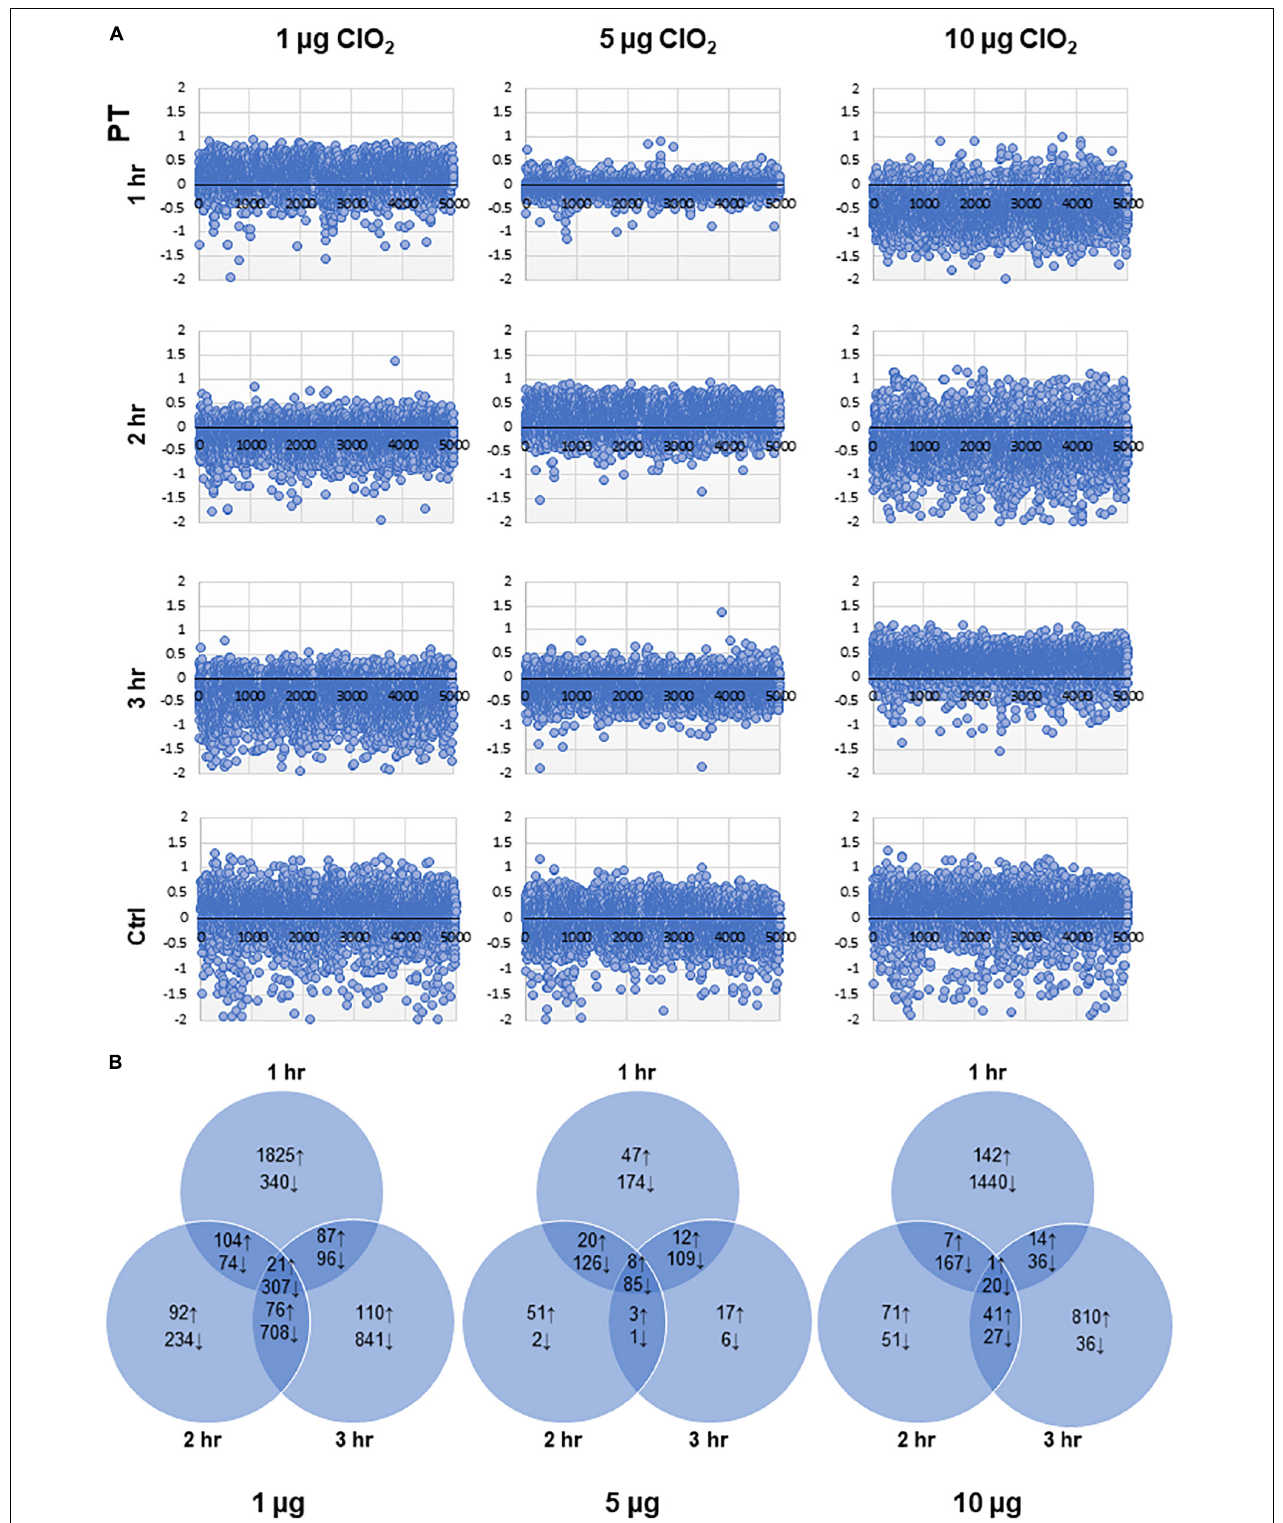
FIGURE 2 | Dynamic changes in the transcriptomes of E. coli under different doses of ClO 2 . (A) Scatter plots showing the propensity transformation (PT) for each transcriptome library. (B) Venn diagrams showing the total number of upregulated ( ↑ ) and downregulated ( ↓ ) genes according to whether they are specific to exposure time or shared across time points for each dose of ClO 2